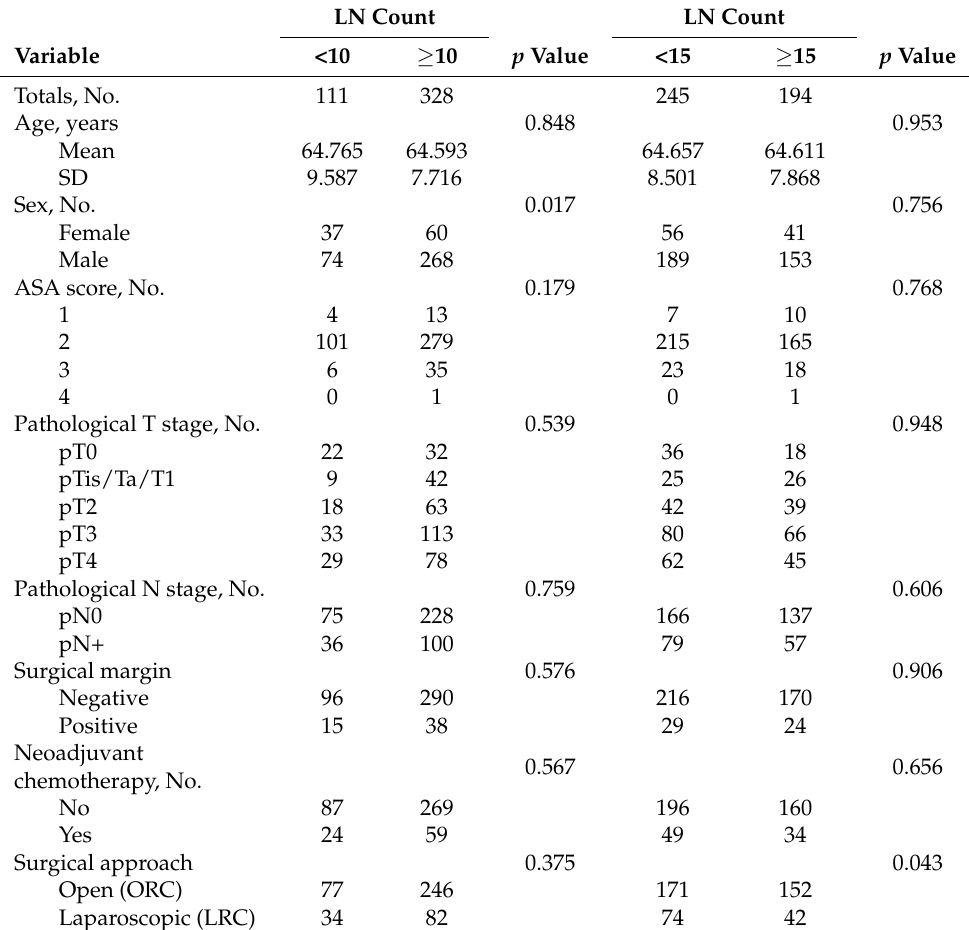
Table 1. Baseline patients’ characteristics. LN Count LN